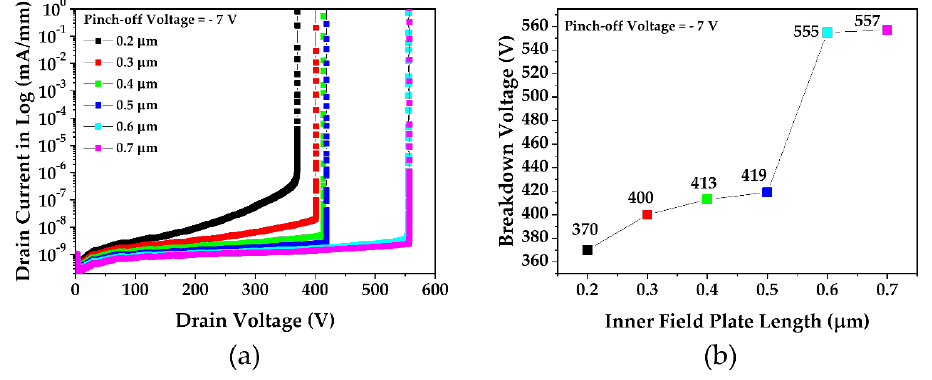
Figure 8. ( a ) Drain leakage current characteristics of AlGaN/GaN HEMT in a log scale and ( b ) breakdown voltage of the device as a function of IFP lengths.